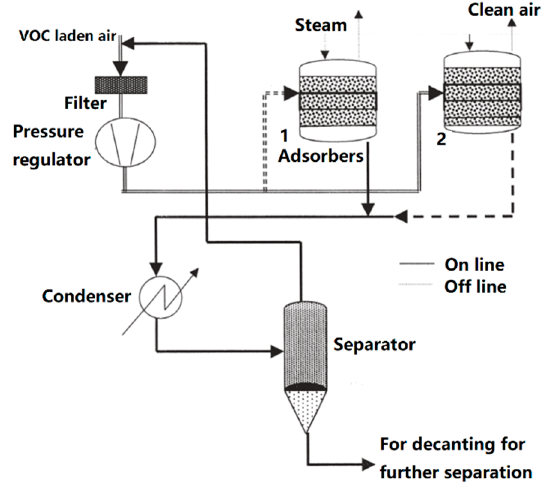
Figure 3. A typical activated carbon VOC removal (solvent recovery) plant. Reprinted with permission from [26], 2000, Elsevier Ltd.